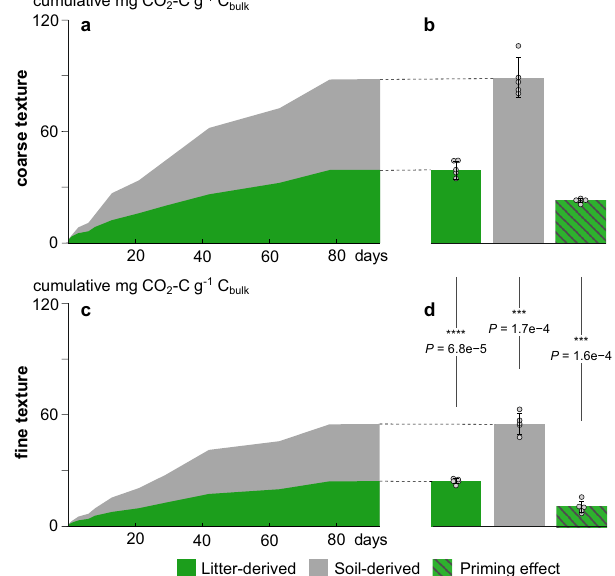
Fig. 1 Cumulative heterotrophic respiration in fi ne-textured and coarse- textured soil. Respired CO 2 -C g − 1 C bulk during the 95-day incubation in ( a / b ) coarse-textured and ( c / d ) fi ne-textured soil. The total respired CO 2 -C in soil with ( b ) coarser and ( d ) fi ner texture is displayed on the right (means, SDs displayed with errors bars, n = 5 independent replicates), together with the total priming effect. We report CO 2 -derived C per amount C in incubated samples to directly showcase the mechanistic process level. Asterisks represent signi fi cant differences between the textures (*** P < 0.001, **** P < 0.0001). Statistical signi fi cance was analyzed using an unpaired two-sided t